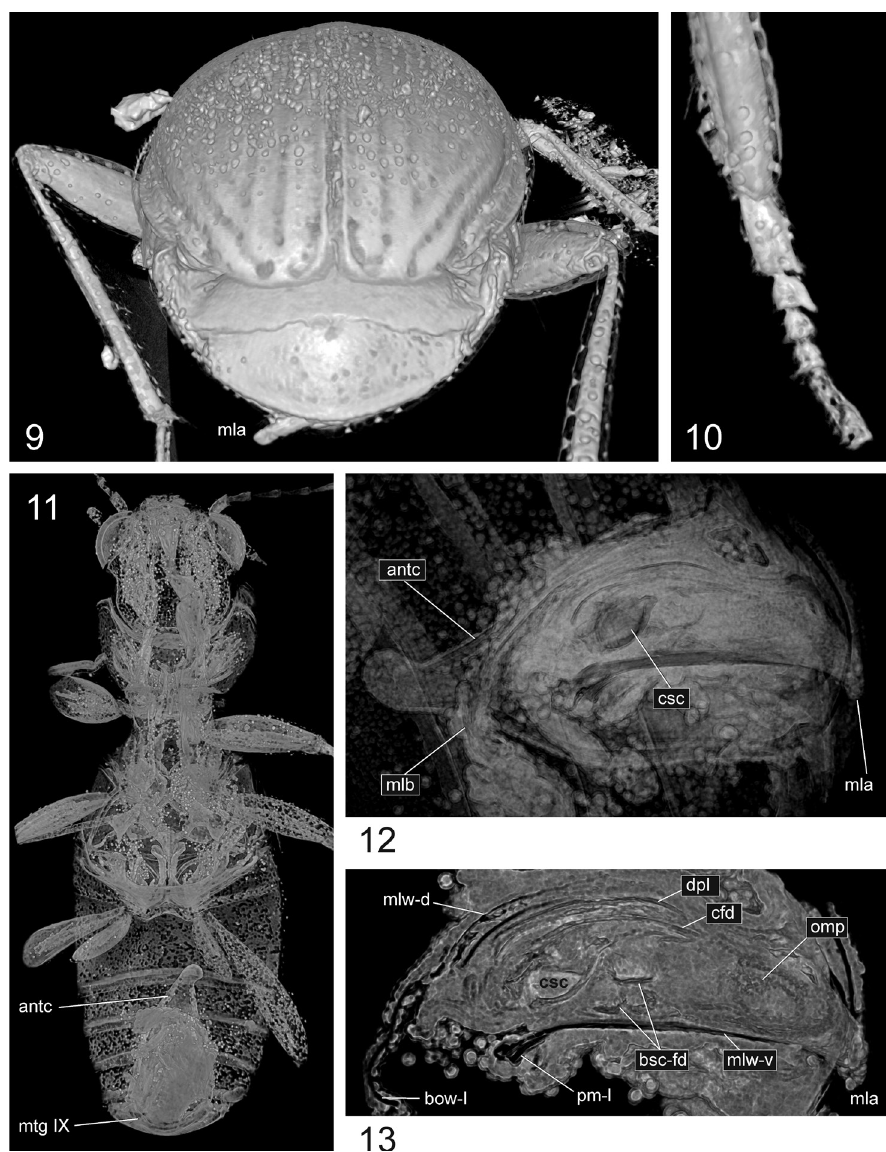
Figures 9–13. Bembidion bukejsi sp. n., holotype, volume rendering of selected body parts 9 caudal aspect of body 10 tarsomeres and distal portion of tibia of right proleg. 11 frontal section of body (ven- tral aspect) showing position of the abdominal segment IX which surrounds the aedeagus 12 abdominal segment IX and aedeagal median lobe, left lateral aspect 13 sagittal section of aedeagal median lobe, left lateral aspect. Abbreviations: antc = antecosta; bow-l = left wall of basal orfice; bsc-fd = folding structures originating from the endophallic brush sclerite; cfd = central folding system of endophallus; csc = central sclerite of endophallus (left lobe); dpl = dorsal plate of endophallus; mla = aedeagal median lobe apex; mlb = aedeagal median lobe base; mlw-d = dorsal wall of median lobe; mlw-v = ventral wall of median lobe; mtg IX = mediotergite IX; omp = ostial microtrichial patch; pm-l = left paramere (basal